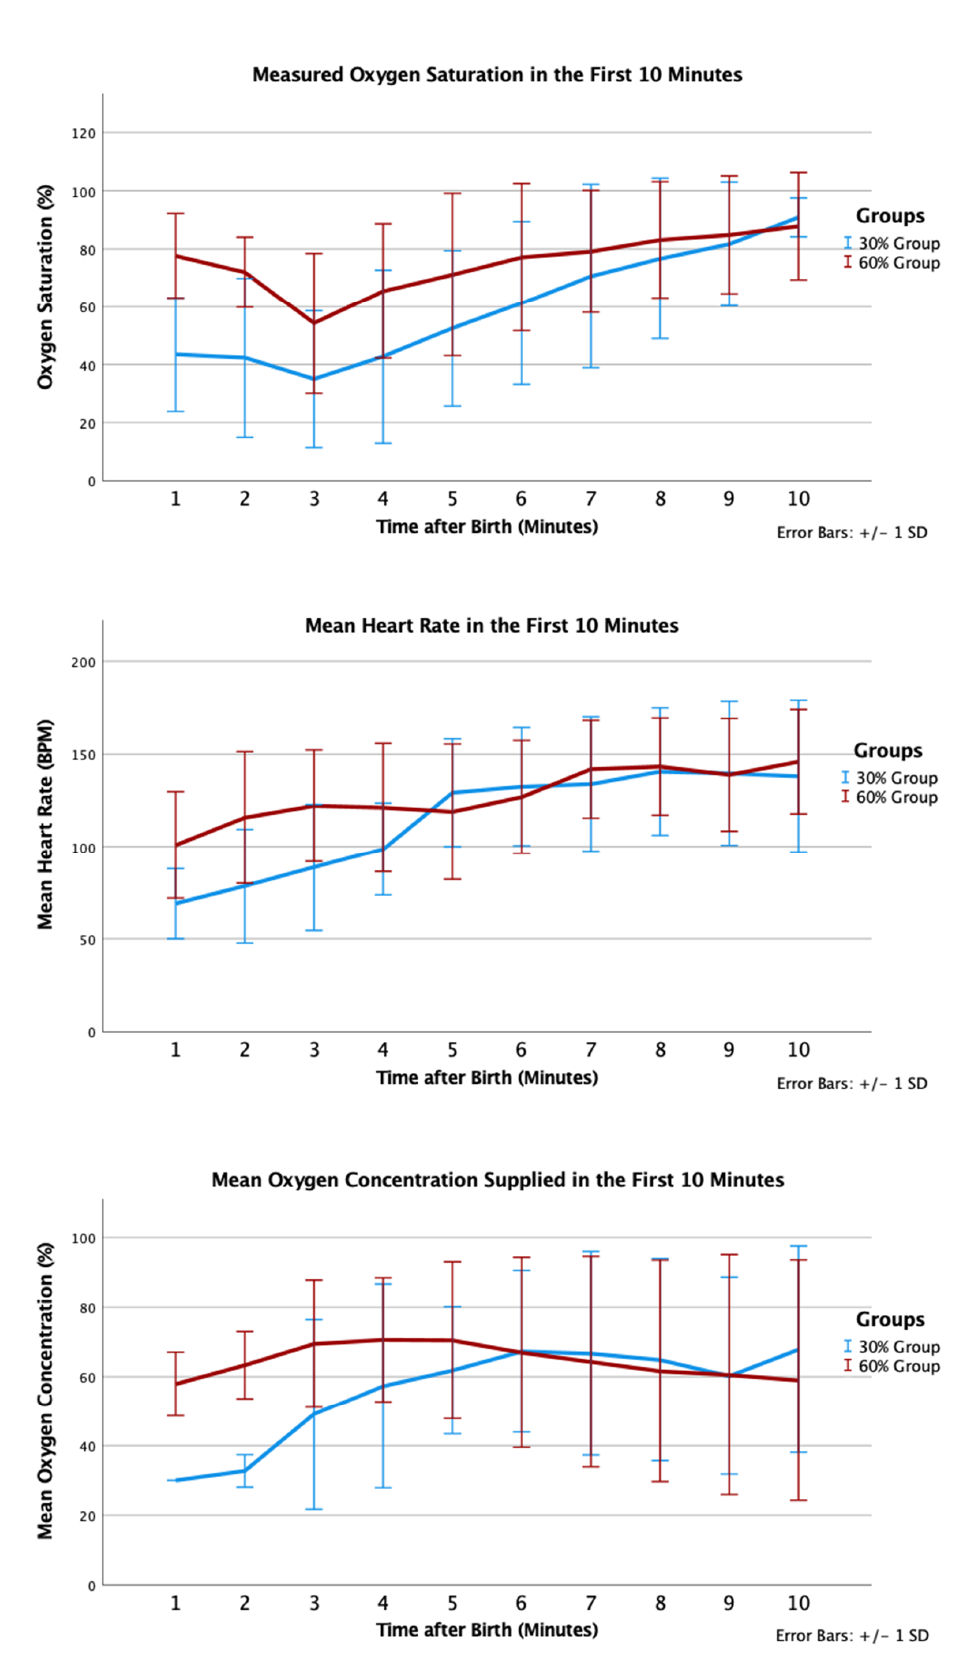
Figure 4. Mean oxygen saturation (%), oxygen saturation (%), and heart rate (bpm) in the first 10 min after birth according to group